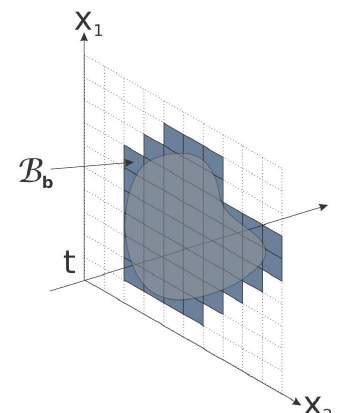
Figure A1. Admissible state-space discretization and I Ω ( b ) membership function